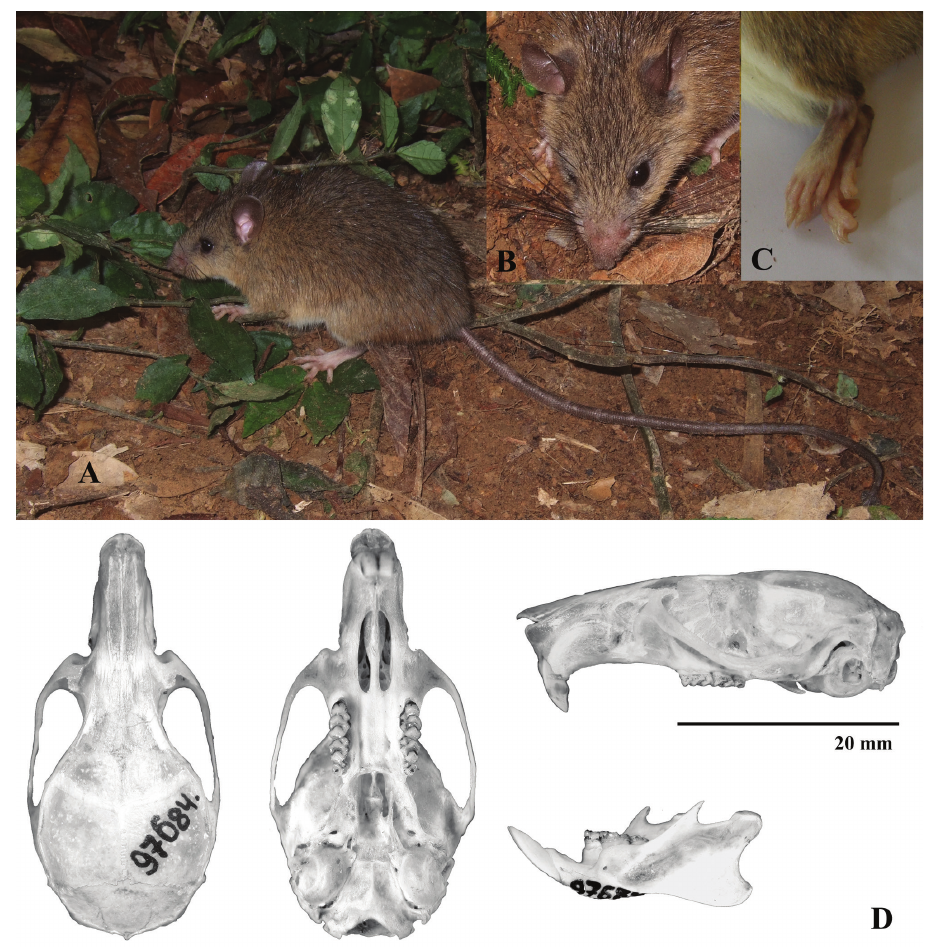
Figure 3. Chiromyscus langbianis , Bi Dup-Nui Ba Nature Reserve, Dalat Plateau, southern Vietnam. A General appearance (photo by Alexei V. Abramov), ZIN 96679, genetic voucher BD9 B Head, dorsal view C Hind foot, dorsal view D Skull, ZIN